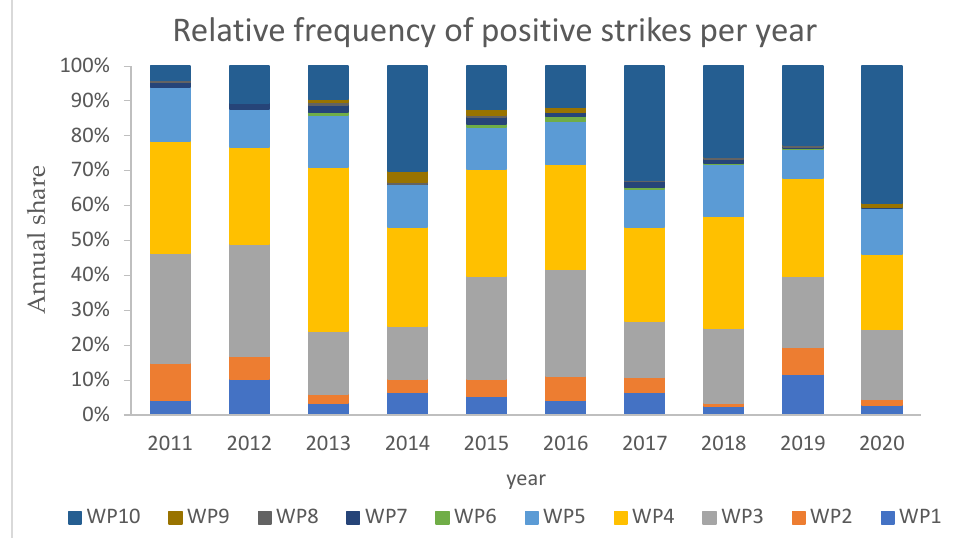
Figure 2. Relative share of the annual positive strikes of each wind park as a percentage of the total positive strikes recorded per year.